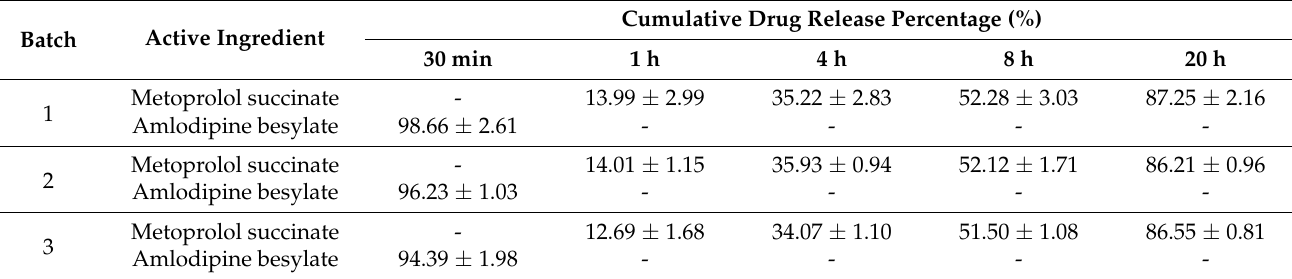
Table 11. Dissolution test of film-coated bi-layer tablet of three batches.